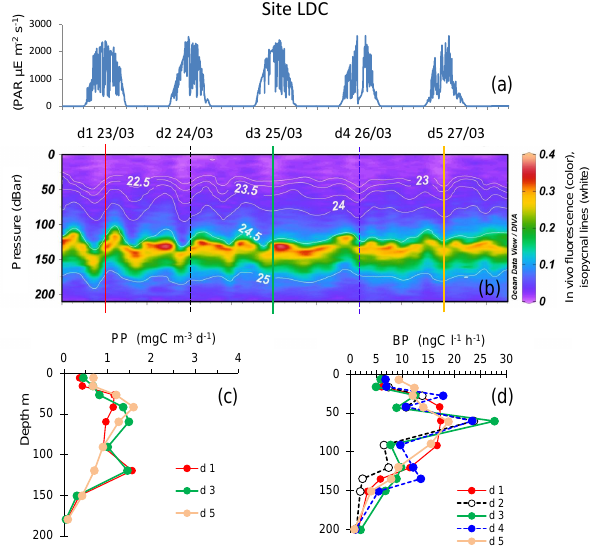
Figure 6. Evolution of surface PAR (a) , in vivo fluorescence and pycnoclines (b) , PP (c) and BP (d) at site LDB. Time units in local time; day 1 was 15 March 2015. BP samples were taken at the 12:00 ctd cast, while samples for PP insitu were taken at the 03:00 ctd casts (days 1, 3 and 5). In graph (b) in vivo fluorescence is in color, isopy- cnes (kgm − 3 ) are the white lines and vertical bars show the 12:00 ctd cast sampled for BP each day (1 to 5), with corresponding colors used for plotting BP vertical profiles in (d) .